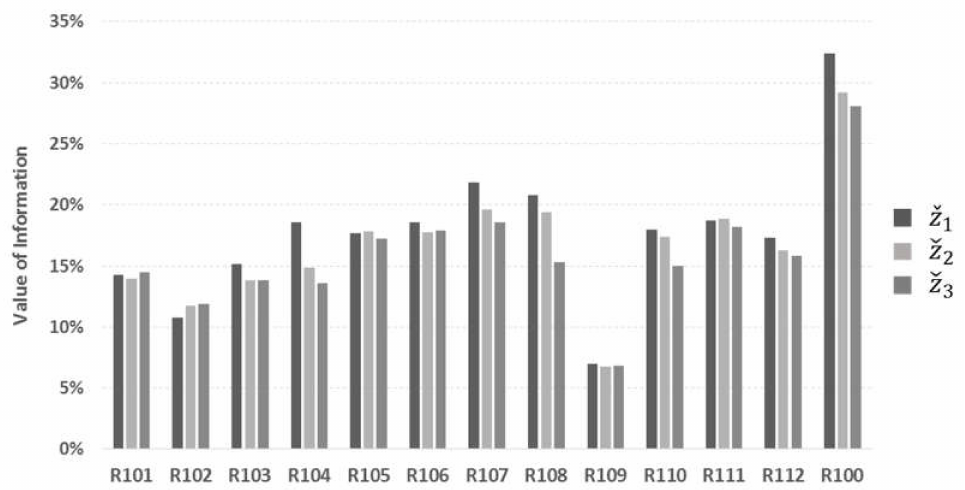
Figure 6. Overall average performance of objectives per investigated instance.